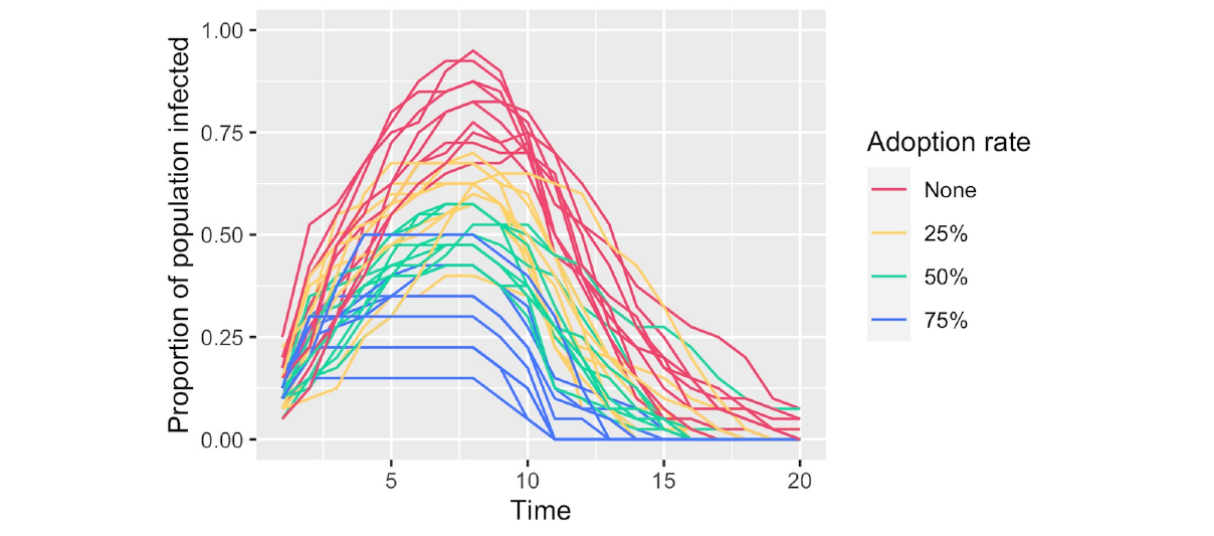
Figure 3. Comparison of infection curves from simulations at varying rates of peer-to-peer contact tracing application adoption. The proportion of the population with active infection is plotted across time for multiple adoption rates. Time is an arbitrary unit that represents the sequence of events in the simulation. The results of 10 random simulations per adoption rate are given.